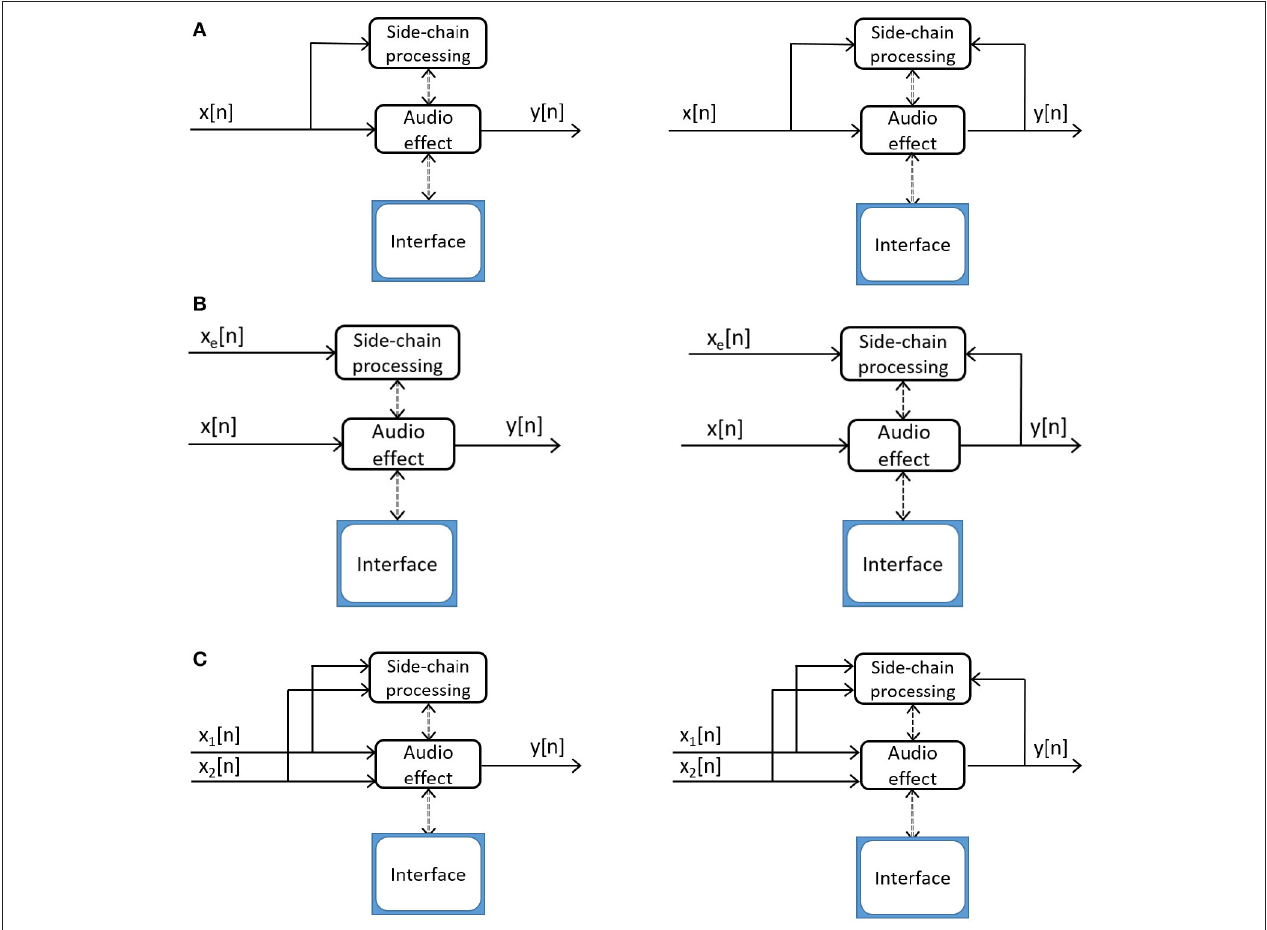
FIGURE 1 | Depictions of audio effects distinguished by their control. (A) Auto-adaptive processing device without (left) and with (right) feedback. (B) Cross-adaptive processing device without (left) and with (right) feedback, where x e ( n ) is the external source. If x e ( n ) is not heard in the output, and only affects y ( n ) via modulation of x ( n ), then the effect is external-adaptive. (C) Cross-adaptive processing device with multiple inputs x 1 ( n ) and x 2 ( n ), creating one output y ( n ). The parametric control of the effect processing then can be affected by the relation between feature vectors of the two signals. Without (left) and with (right)